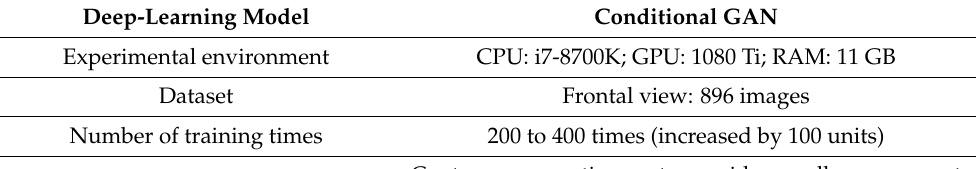
Table 1. Experimental environment and design.